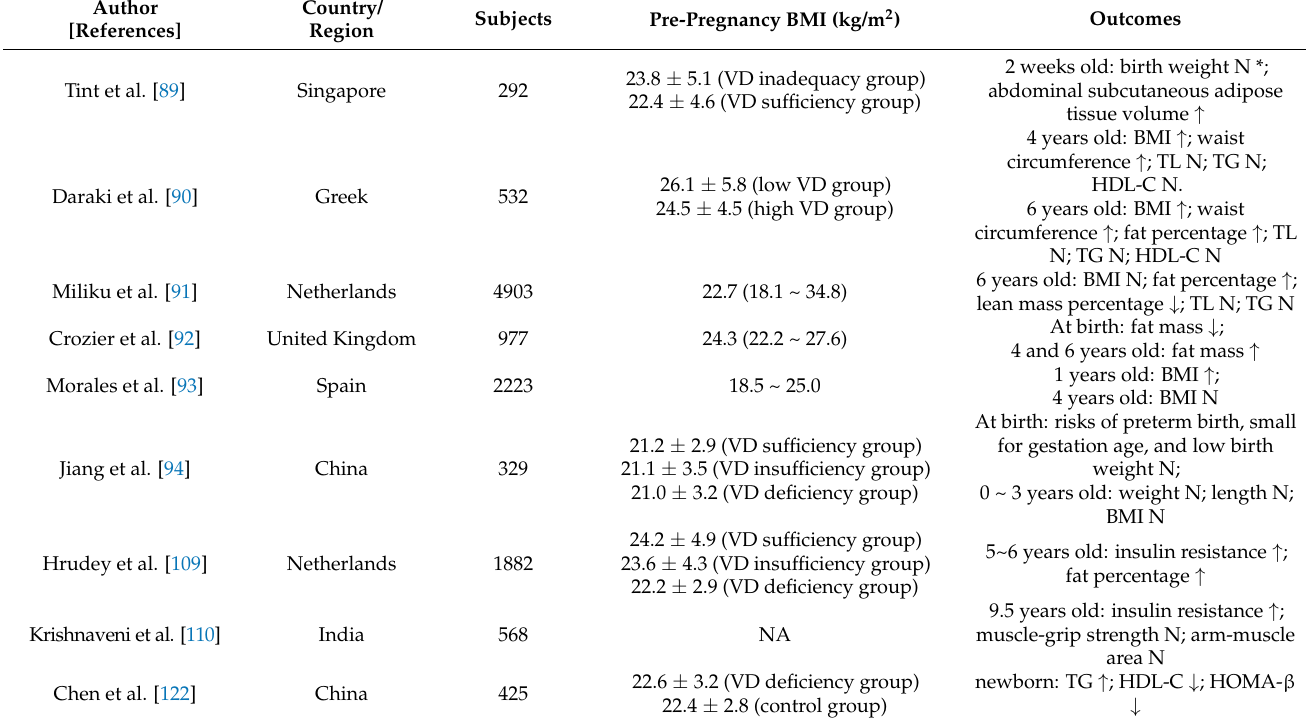
Table 1. Cohort studies on VD deficiency during pregnancy and obesity and its related diseases in